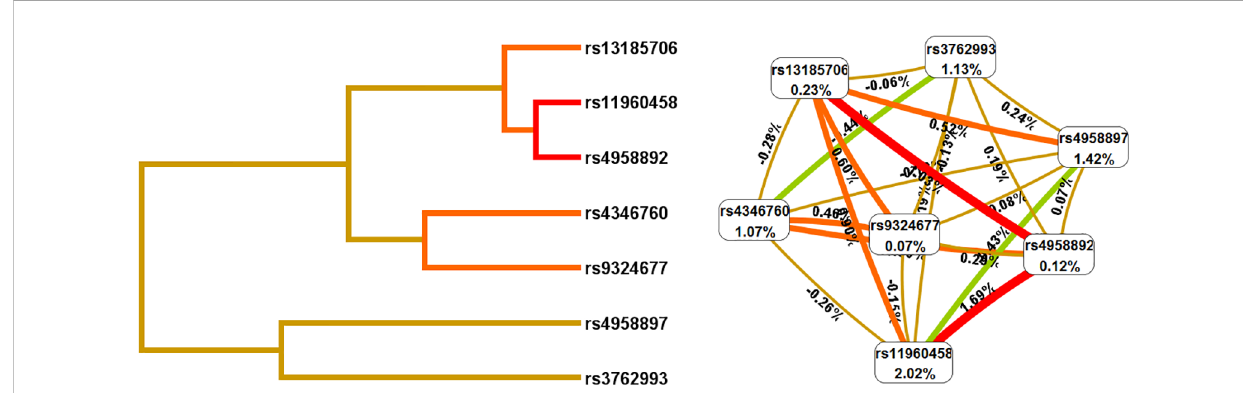
FIGURE 1 The SNP-SNP interaction analysis (Dendrogram and Fruchterman-Reingold). The colors represent synergy or redundancy. Green and blue with a negative correlation; red, orange and brown with a positive